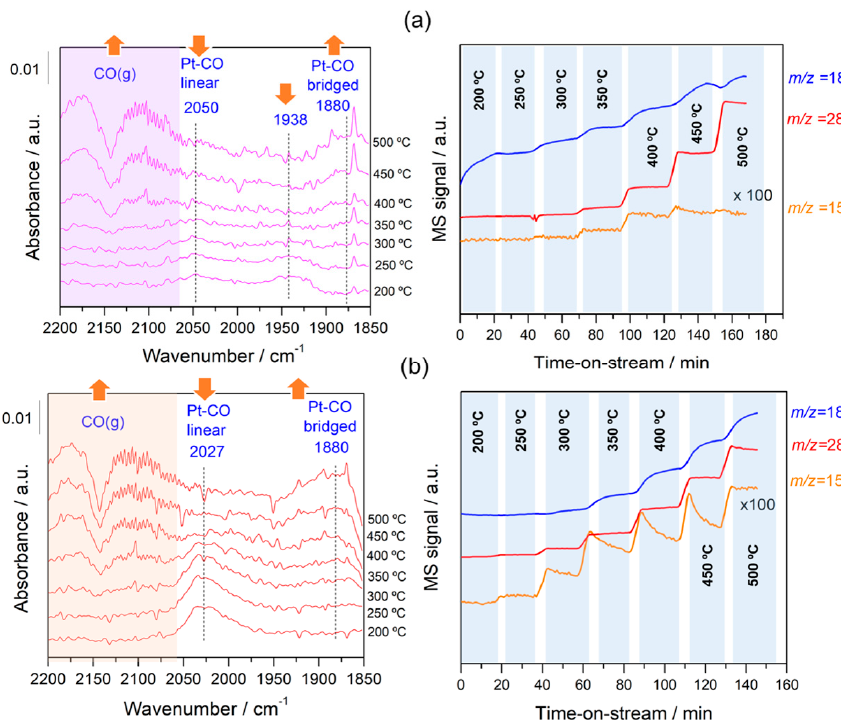
Figure 7. Evolution of difference DRIFT spectra and gas-phase species produced as a function of the rWGS reaction temperature for the samples ( a ) Pt/C and ( b ) Pt–Na/C. The reference spectrum was recorded after activation at 200 °C. The amount of H 2 O, CO, and CH 4 was measured with a mass spectrometer located at the exit of the DRIFTS cell.